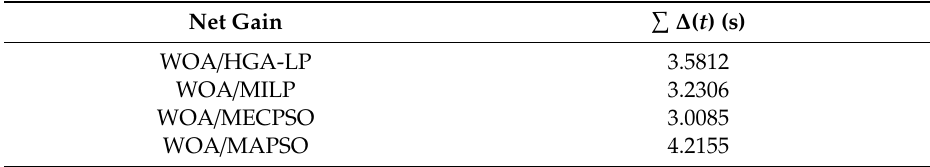
Table 23. Comparison of total net gain in time achieved by the WOA with the methods used in the literature for the IEEE 14-bus